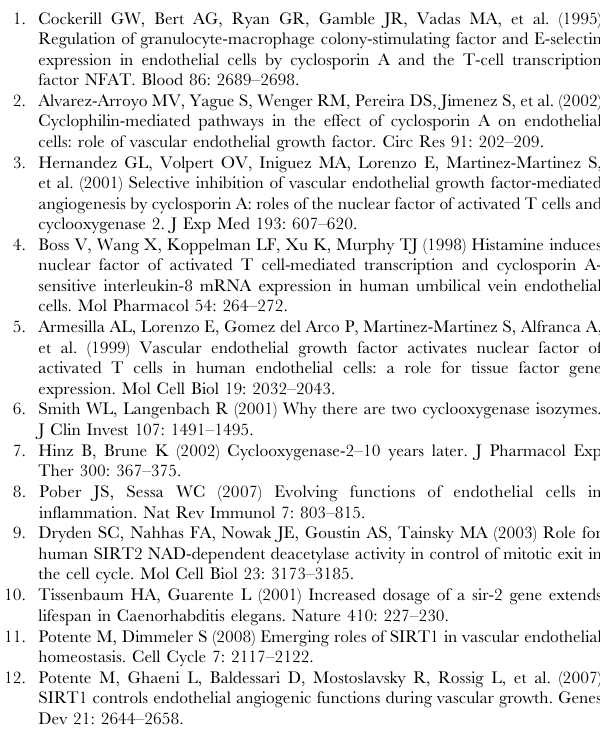
Figure S2 SIRT2 does not affect NFAT transcriptional activity. HEK293 cells were transfected with 0.1 m g NFAT